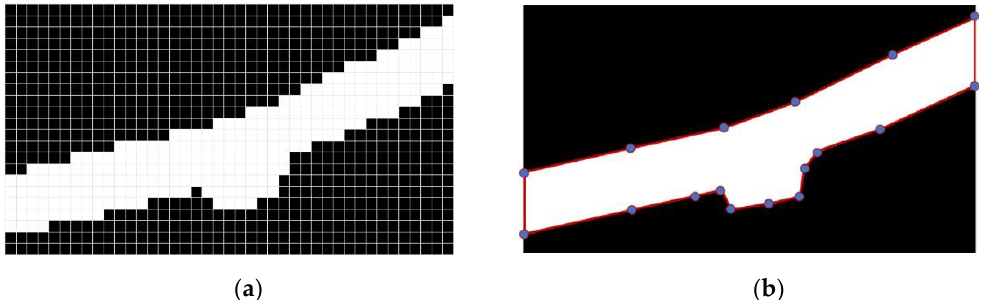
Figure 5. Comparison of the rasterized map and vectorized map. ( a ) The rasterized map; ( b ) the vectorized map.